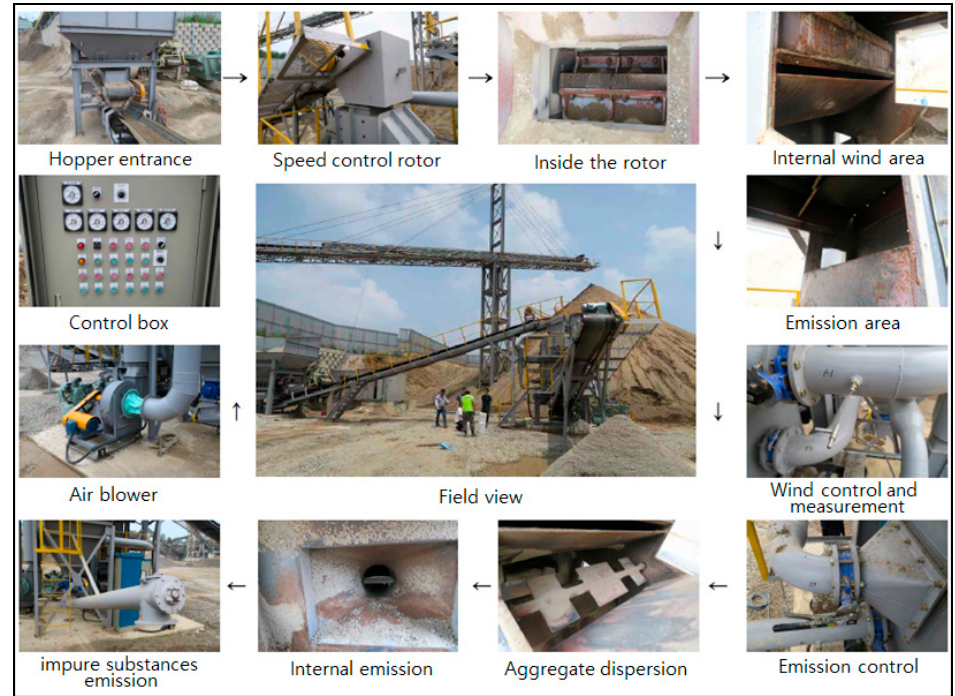
Figure 4. The production process of the technology development scheme.